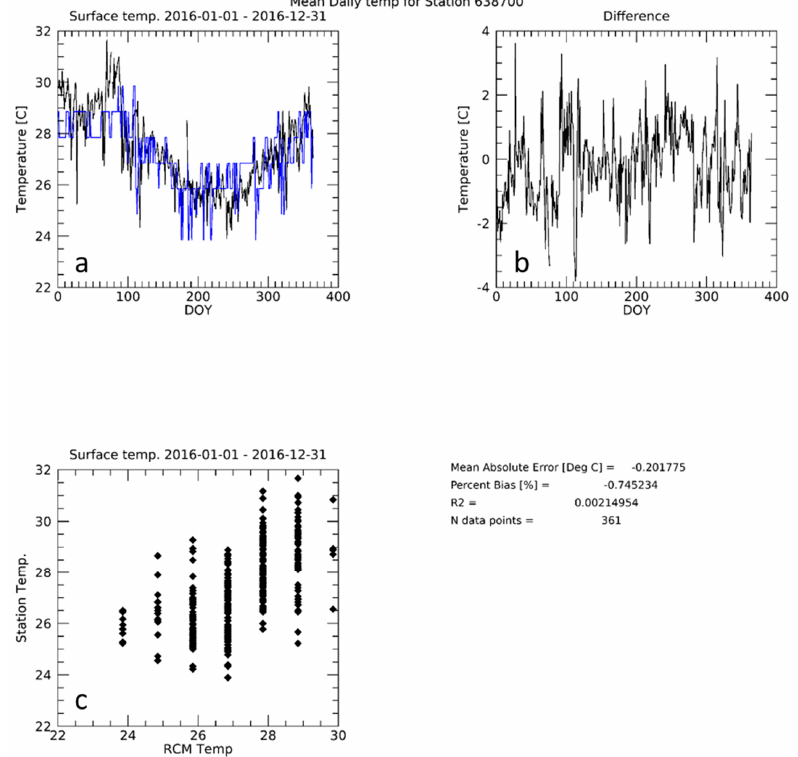
Figure A4. Comparison of mean daily surface temperature from Zanzibar (Station Temp. In graph) versus the mean daily surface temperature from CORDEX (RCM Temp) for the year 2016. ( a ) The mean daily observed temperature is in black and the CORDEX temperature is in blue. ( b ) Daily temperature difference (observed-CORDEX) and ( c ) scatterplot of observed versus estimated (RCM) temperature.